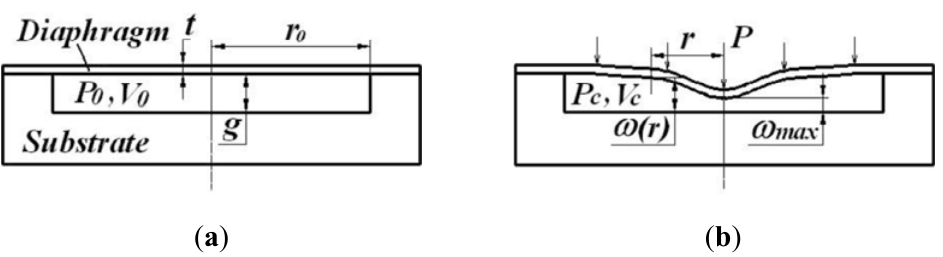
Figure 1. Working principle of the atmospheric pressure sensor. ( a ) in the case that ambient pressure is identical to the initial pressure of the cavity. ( b ) in the case that ambient pressure